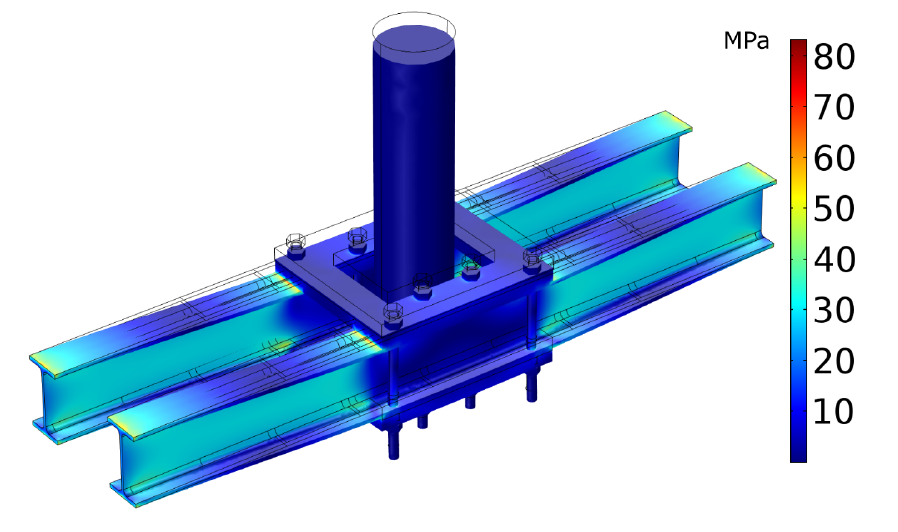
Figure 4. Stress distribution of maximum stress component: actuator attachment.